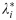
Optimal transition rates λi* as a function of site index i for an RFM with n = 11 sites.Data obtained by solving the translation maximization problem (Problem 1) with the homogeneous constraint (12). It may be seen that the optimal transition rates λi*s are symmetric around the center of the chain, with higher values at the center of the chain.